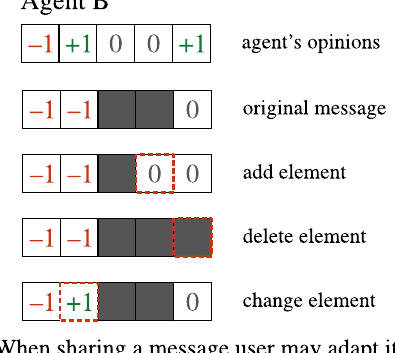
Figure 7. Creation of new messages and possible adaptation of messages when sharing